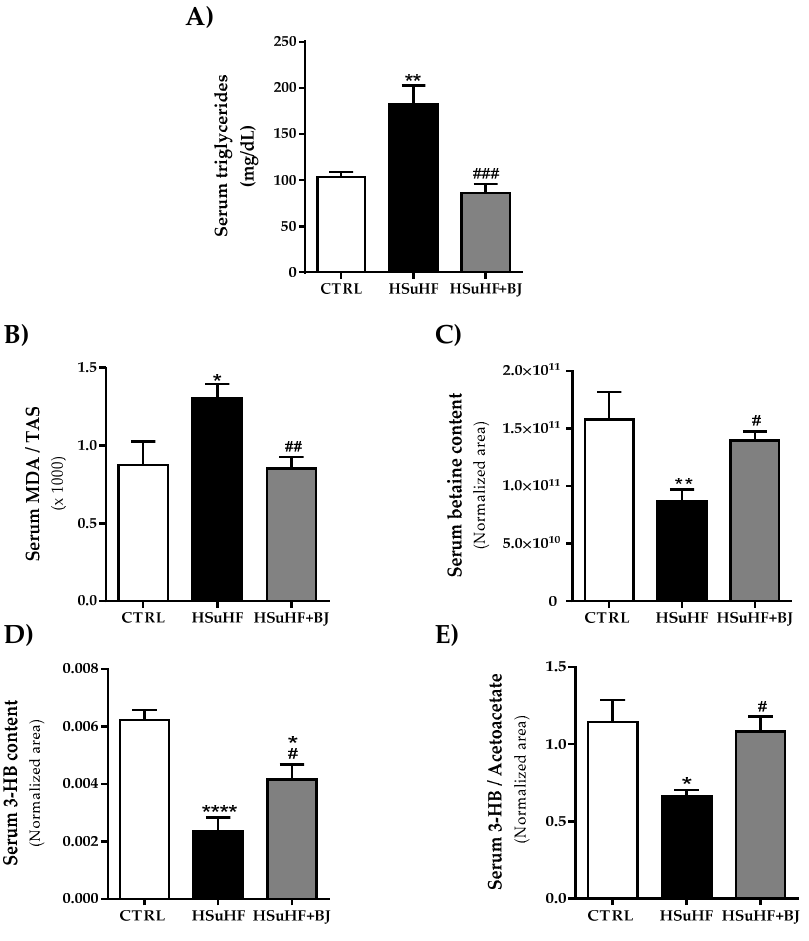
Figure 2. Effects of BJ on serum triglycerides contents ( A ) and on serum redox marker ( B ). Serum contents of betaine ( C ). Serum levels of 3-hydroxybutyrate (3-HB) ( D ) and 3-HB/acetoacetate ratio ( E ) in CTRL, HSuHF, and HSuHF + BJ groups. Results are expressed as the mean ± SEM. ( n = 8–10/group); * p < 0.05, ** p < 0.01 and **** p < 0.0001 vs. CTRL; # p < 0.05, ## p < 0.01, and ### p < 0.001 vs. HSuHF. CTRL: control. HSuHF: high sucrose / high-fat. BJ: blueberry